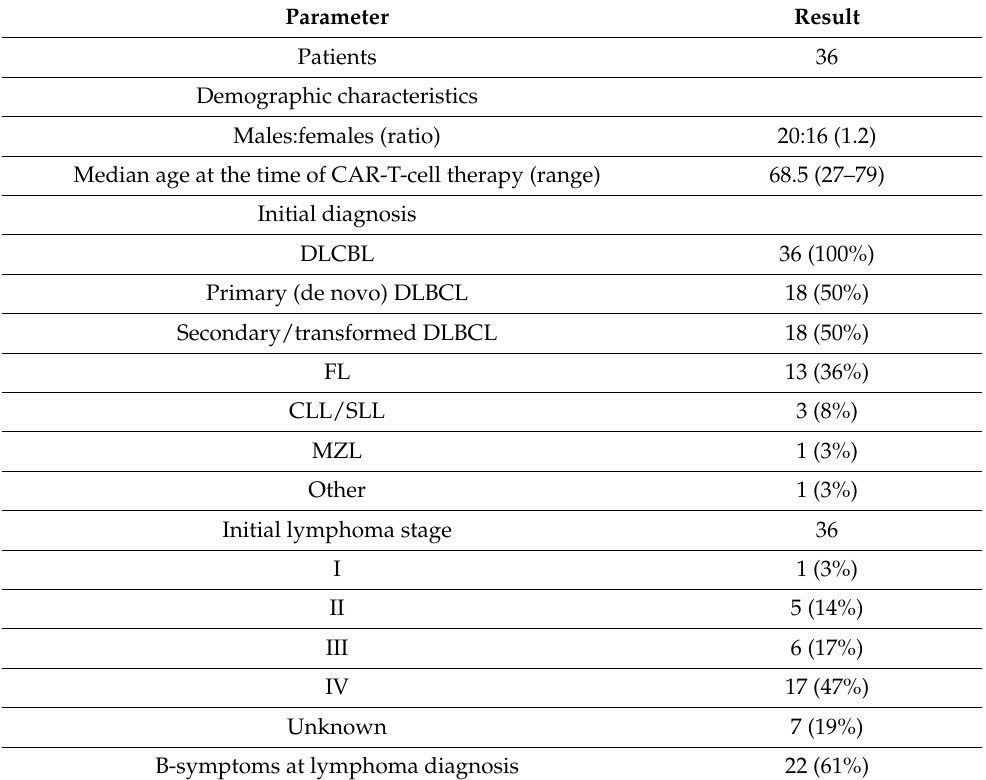
Table 1. Clinical characteristics of the